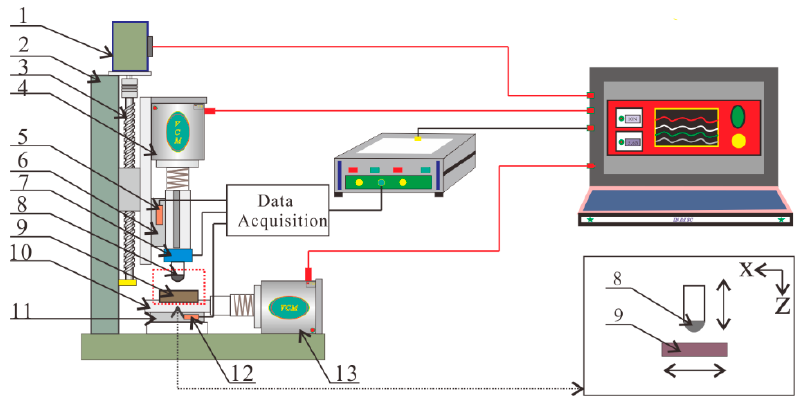
Figure 2. Schematic diagram of the impact-sliding fretting wear test rig. 1 . Servo motor, 2 . Frame, 3 . Lead screw, 4 . Z-direction voice coil motor, 5 . Z-direction displacement transducer, 6 . Z-direction liner slider, 7 . 2-D force sensor, 8 . Impact head, 9 . Test specimen, 10 . Sample clamp, 11 . X-direction liner slider, 12 . X-direction displacement transducer 13 . X-direction voice coil motor.